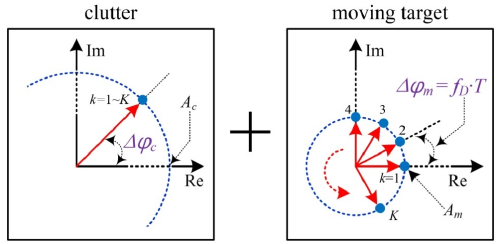
Figure 3. Scheme of the complex results of range-FFT processing in K ramps, consisting of clutter and one moving pedestrian at one r th range-bin: f D is the detected Doppler-frequency by the radial velocity of the pedestrian, ∆ ϕ c is the constant initial phase of clutter, and ∆ ϕ m is the coherent phase difference of the pedestrian.